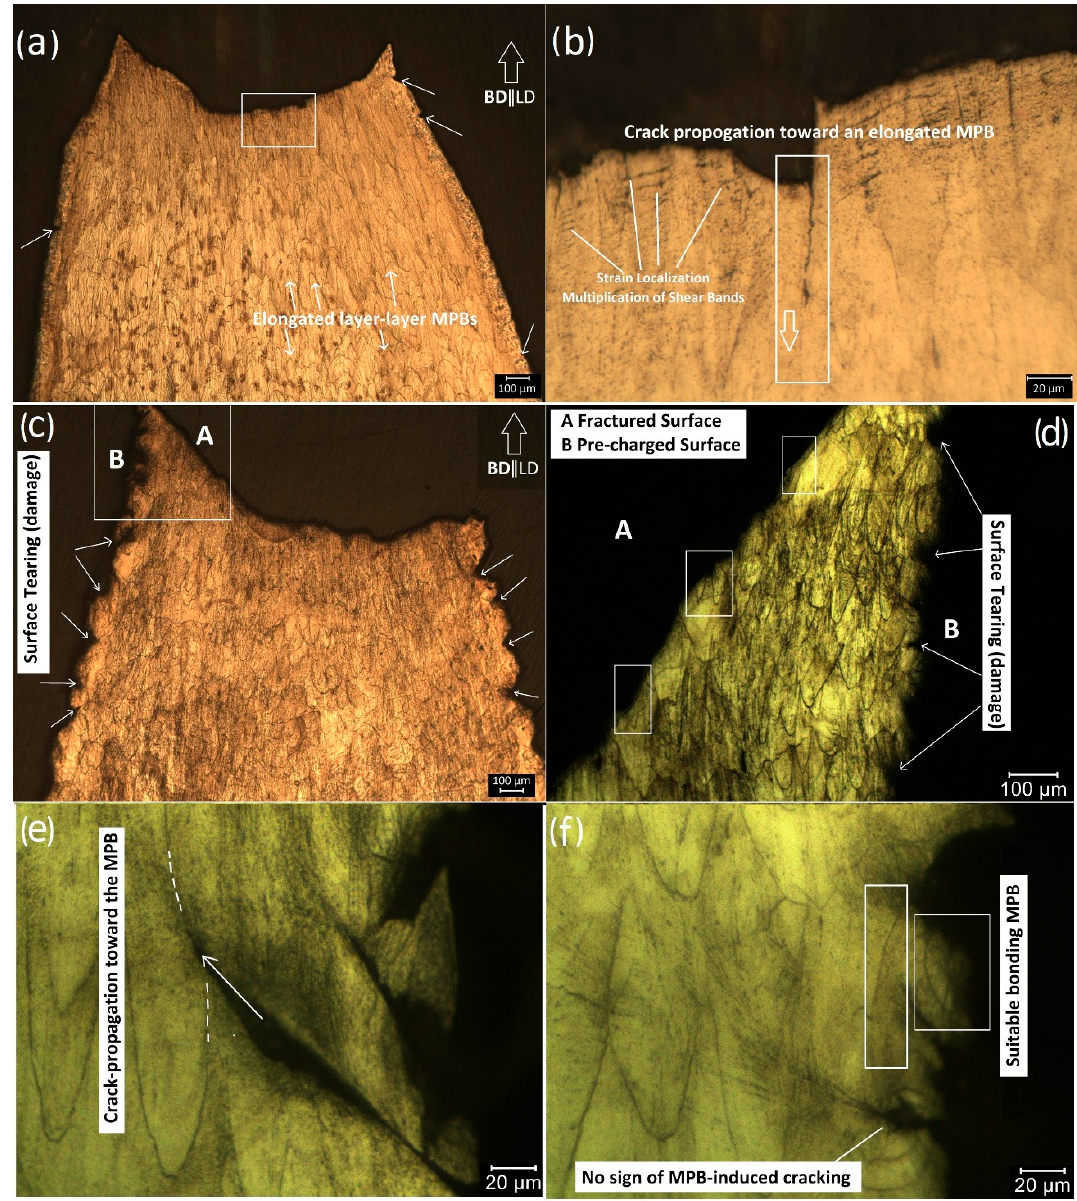
Figure 4. OM micrographs of tensile sample cross-sections after tensile fracture: ( a , b ) UC-1.2 and ( c – f ) C-4.8. A lower surface tearing (damage) is shown by white arrows. Elongated melt pool boundaries (MPBs) toward the building direction (BD) and loading direction (LD) are shown as well. Strain localization and crack propagation toward an MPB are shown on the fracture surface of UC-1.2 ( b ). Severe surface tearing is shown in ( c , d ) using white arrows on the pre-charged surface. No detachment of MPBs is shown in ( d , f ), using white rectangles. Crack-propagation toward the MPB is shown in ( e ). A considerbale rupture can be seen in ( f ) that seems to be independent of MPBs. A shows the fracture surface and B is pre-charged surface.